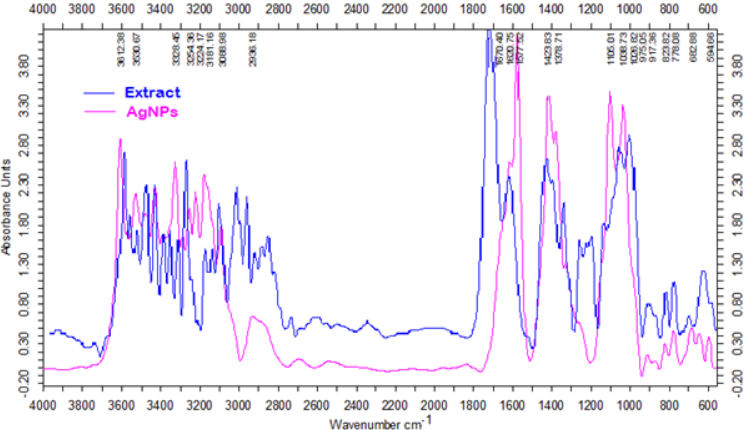
Figure 3. FTIR spectra of Cornelian cherry fruit extract and green synthesized AgNPs.